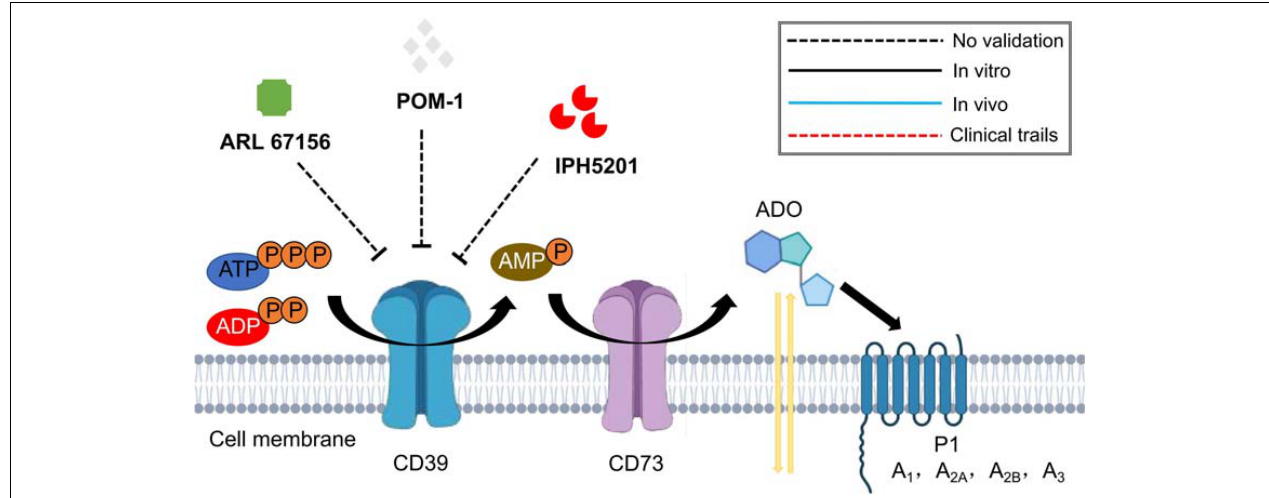
FIGURE 6 | Schematic graph showing potential antifibrotic therapies targeting CD39. (ATP, adenosine triphosphate; ADP, adenosine diphosphate; AMP, adenosine monophosphate; ADO, adenosine).